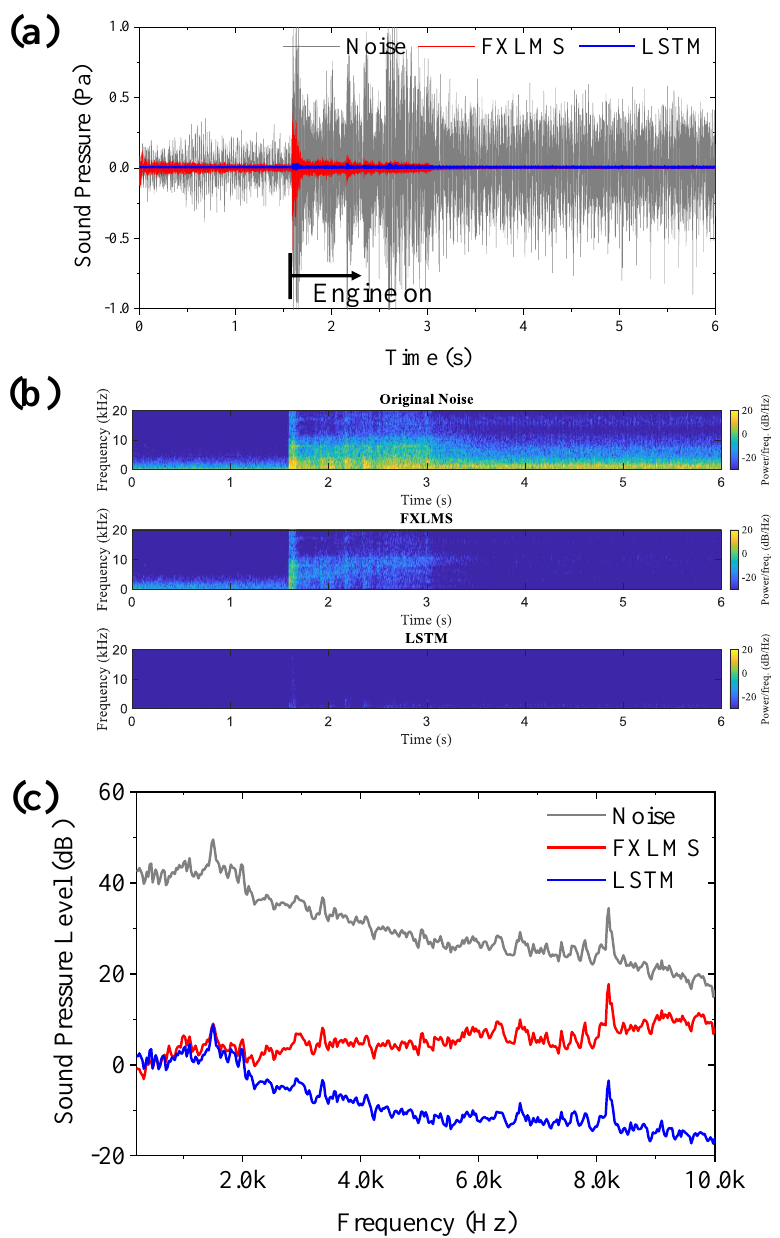
Figure 7. ANC simulation result using FxLMS and LSTM for the impulsive noise signal measured from the start-up of the diesel engine. ( a ) Time data of diesel engine noise and ANC results; ( b ) short-time Fourier transform analysis of original noise and noise residue; ( c ) power spectral density of the diesel engine noise and ANC result in the period when the error signal is minimized.